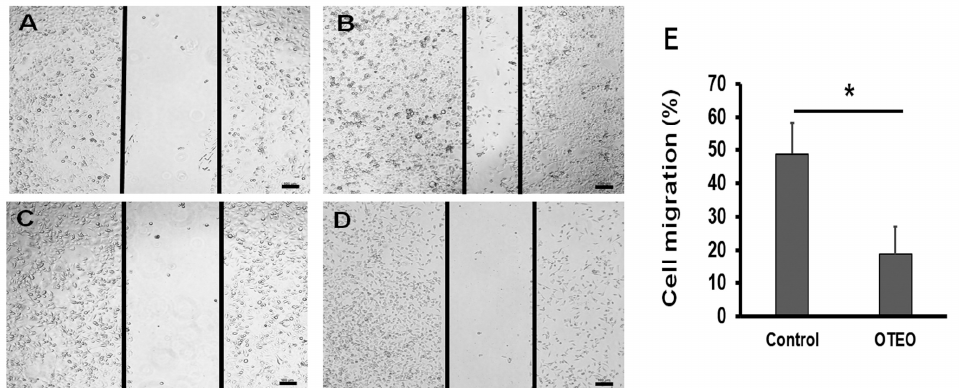
Figure 2. Representative images from wound-healing assays indicating the inhibition of cell migration induced by OTEO in AGS cells: ( A ) AGS control at 0 h, ( B ) AGS control at 24 h, ( C ) AGS treated with OTEO at 0 h, and ( D ) AGS treated with OTEO at 24 h. ( E ) Percent cell migration was calculated by comparing the width of the remaining cell-free area with the width of the initial wound. Data are shown as mean ± SD. Scale bars indicate 100 µm. * p < 0.05 indicated significant difference relative to the control group.